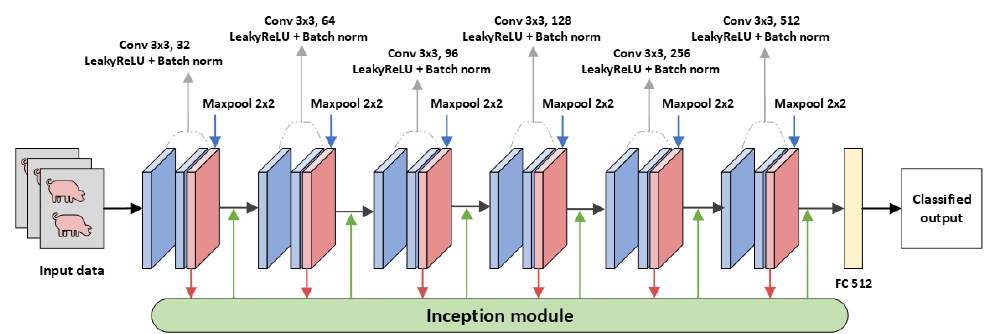
Figure 2. CNN-Inception: Convolution neural network with Inception module.